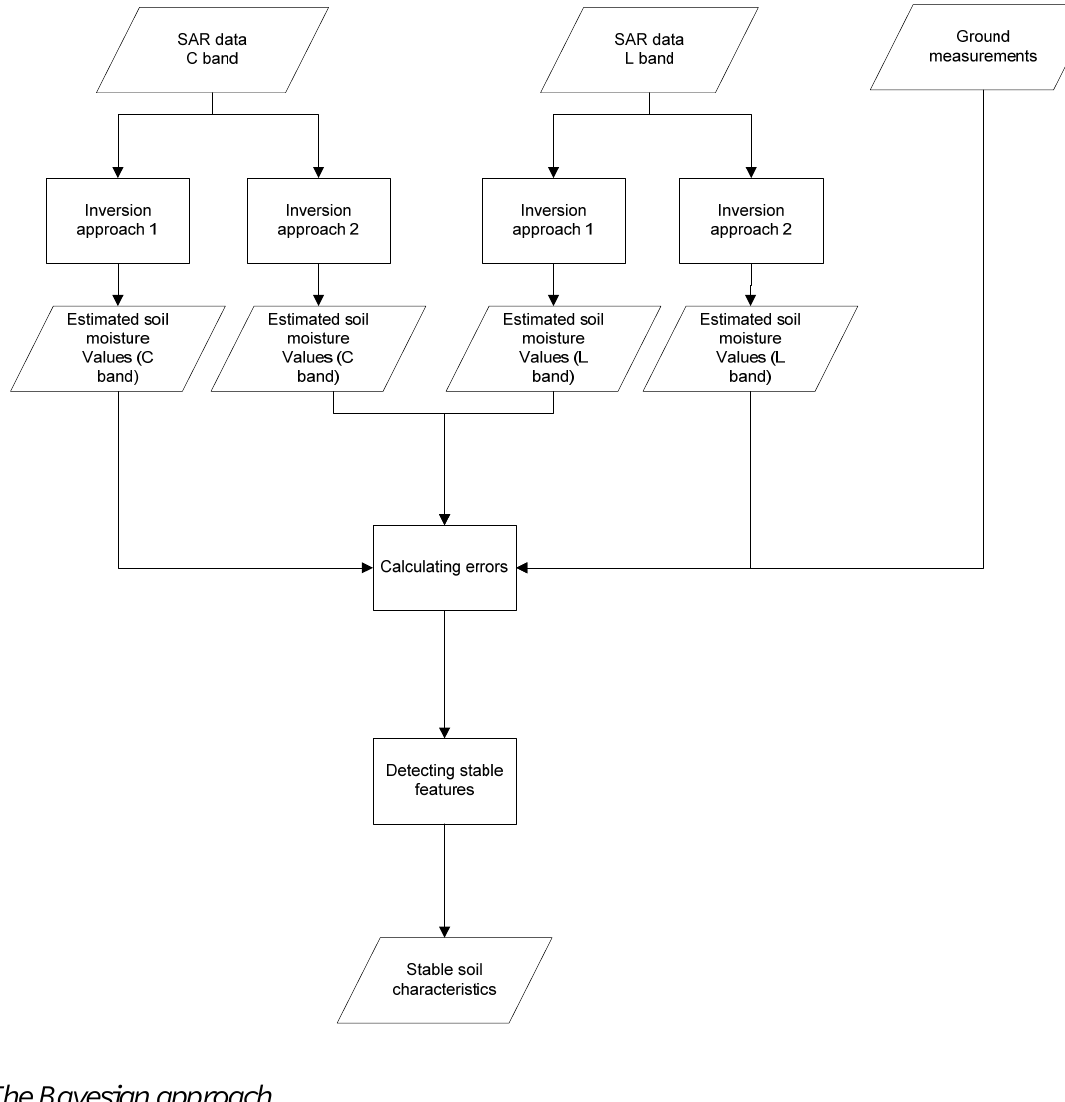
Figure 1 . The overall procedure used to detect soil stable